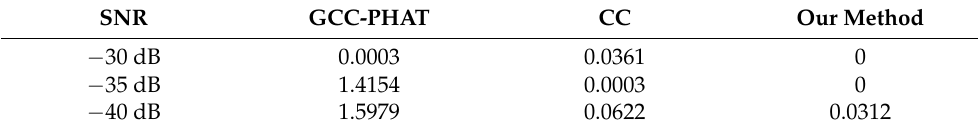
Table 2. Time delay errors in low SNR.